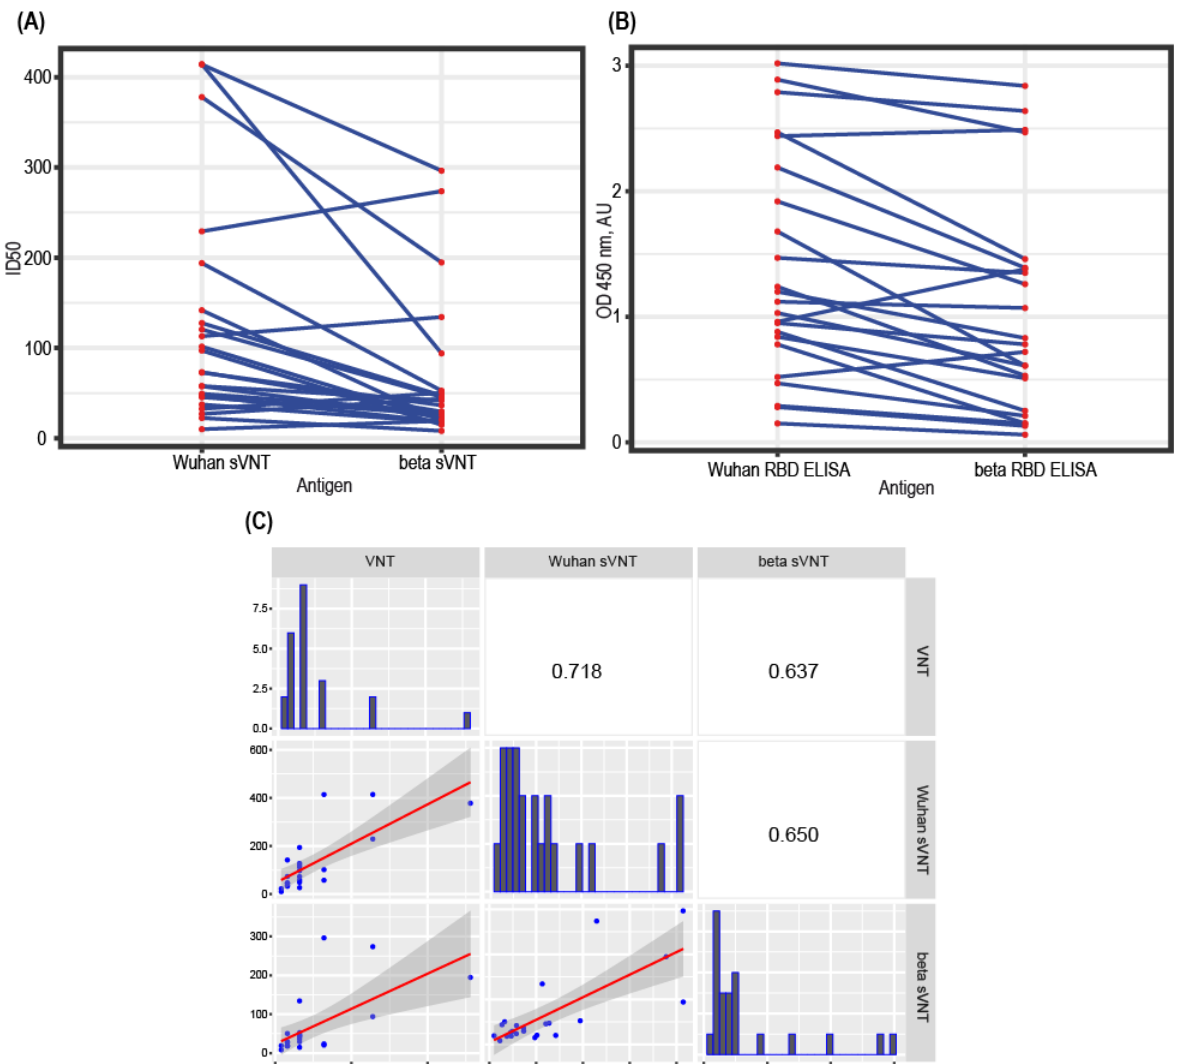
Figure 5. sVNT performance for SARS-CoV-2 variant beta RBD. ( A ) Change in the ID 50 magnitudes for 20 randomly chosen serum samples. ( B ) Change in OD 450 nM in the RBD ELISA test for the same 20 serum samples. ( C ) Correlation analysis matrix for 20 COVID-19 sera—VNT with the wild-type (Wuhan) v of the SARS-CoV-2 virus, sVNT with the variant beta RBD. Calculated characteristic values for each serum: VNT—serum dilution, corresponding to the 50% plaque reduction; sVNT—dilution, corresponding to 50% inhibition of complex formation (ID 50 ); RBD ELISA-OD/CO. Spearman correlation coefficients. The dark areas indicate the standard deviations of the linear regression plots. Samples were analyzed in duplicate for sVNT and RBD